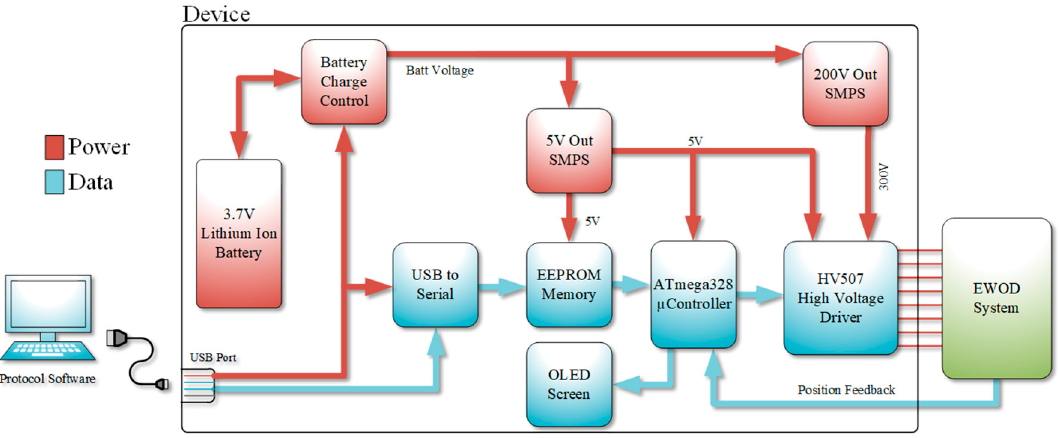
Figure 1. System block diagram.